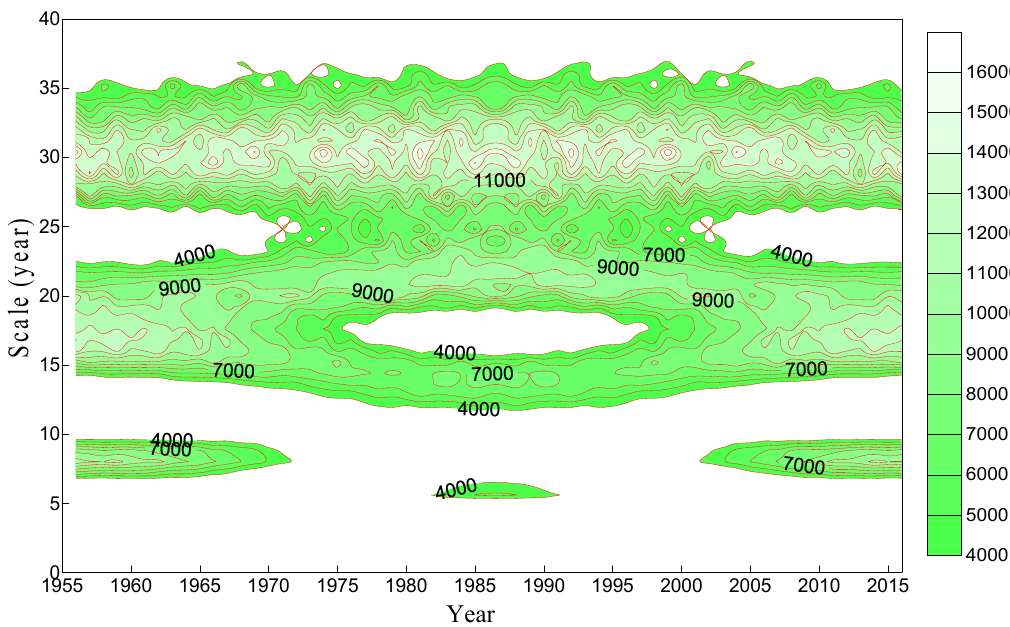
Figure 10. Modulus square of wavelet coefficient contour map of streamflow at Lijin station.